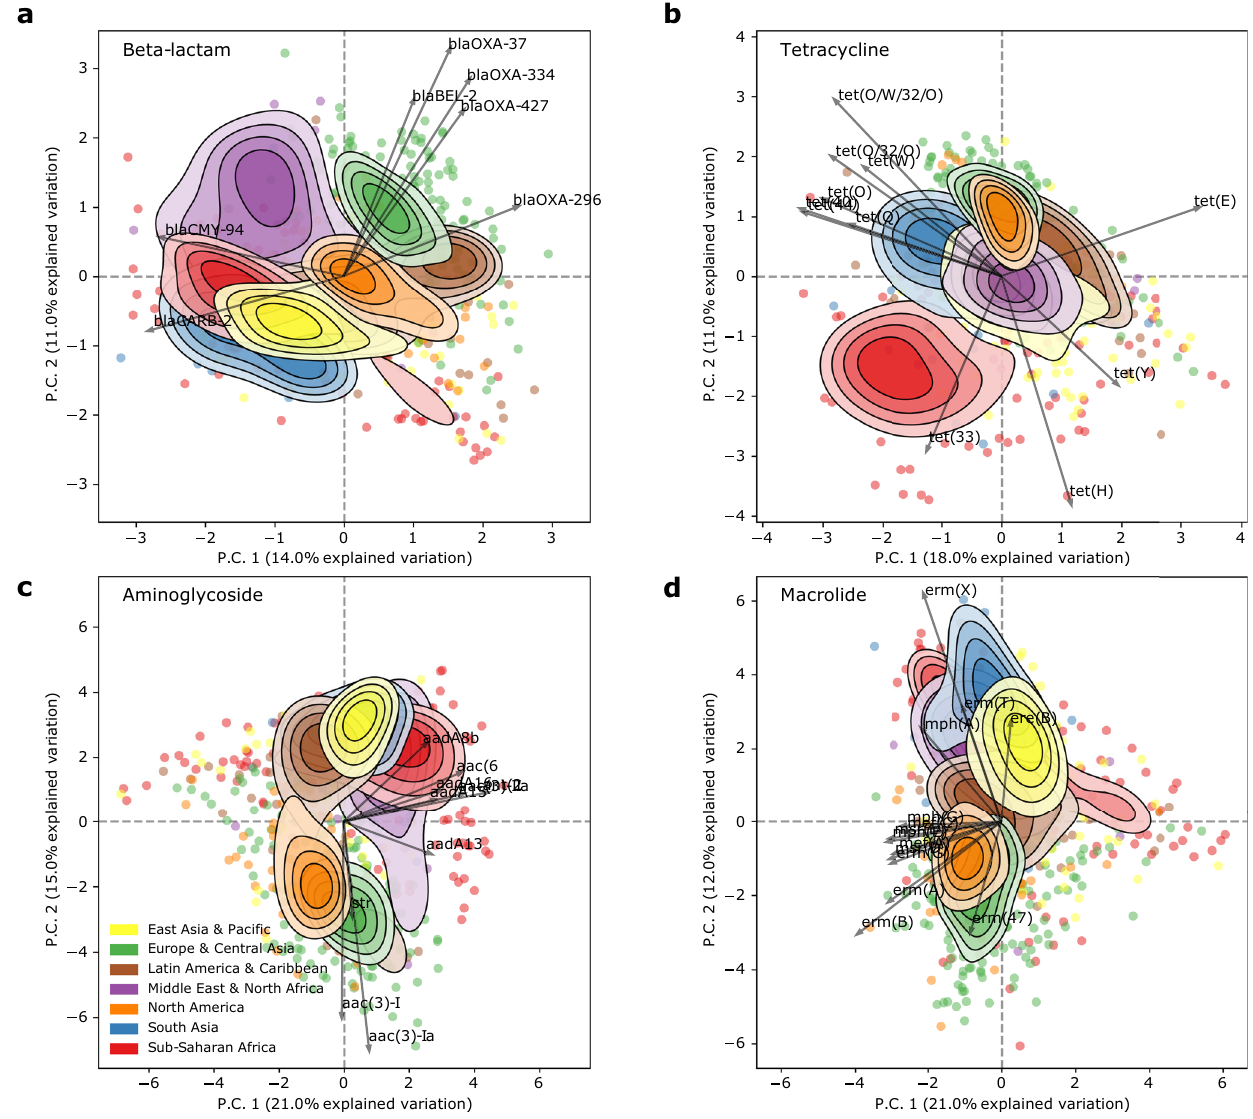
Fig. 3 | Resistome clustering differs by drug class. PCA of the resistome were carried out individually on subsets of ARGs providing resistance to different drug classes. The contours are de fi ned in Fig. 2. Arrows show the ARGs with the highest